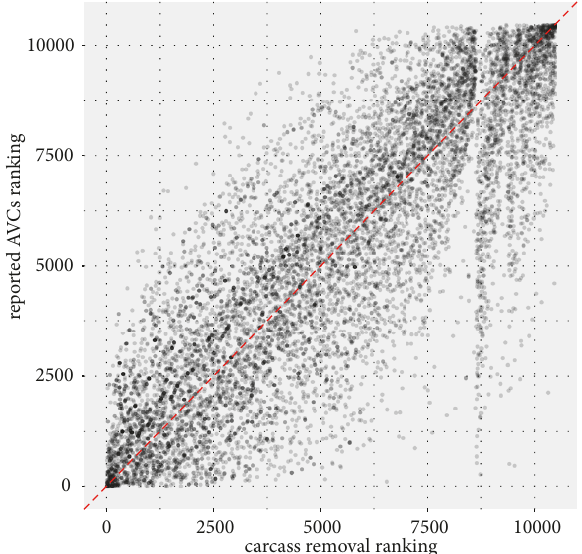
Figure 3: Comparison in HSID ranking by the carcass removal and the reported AVC using NB model.